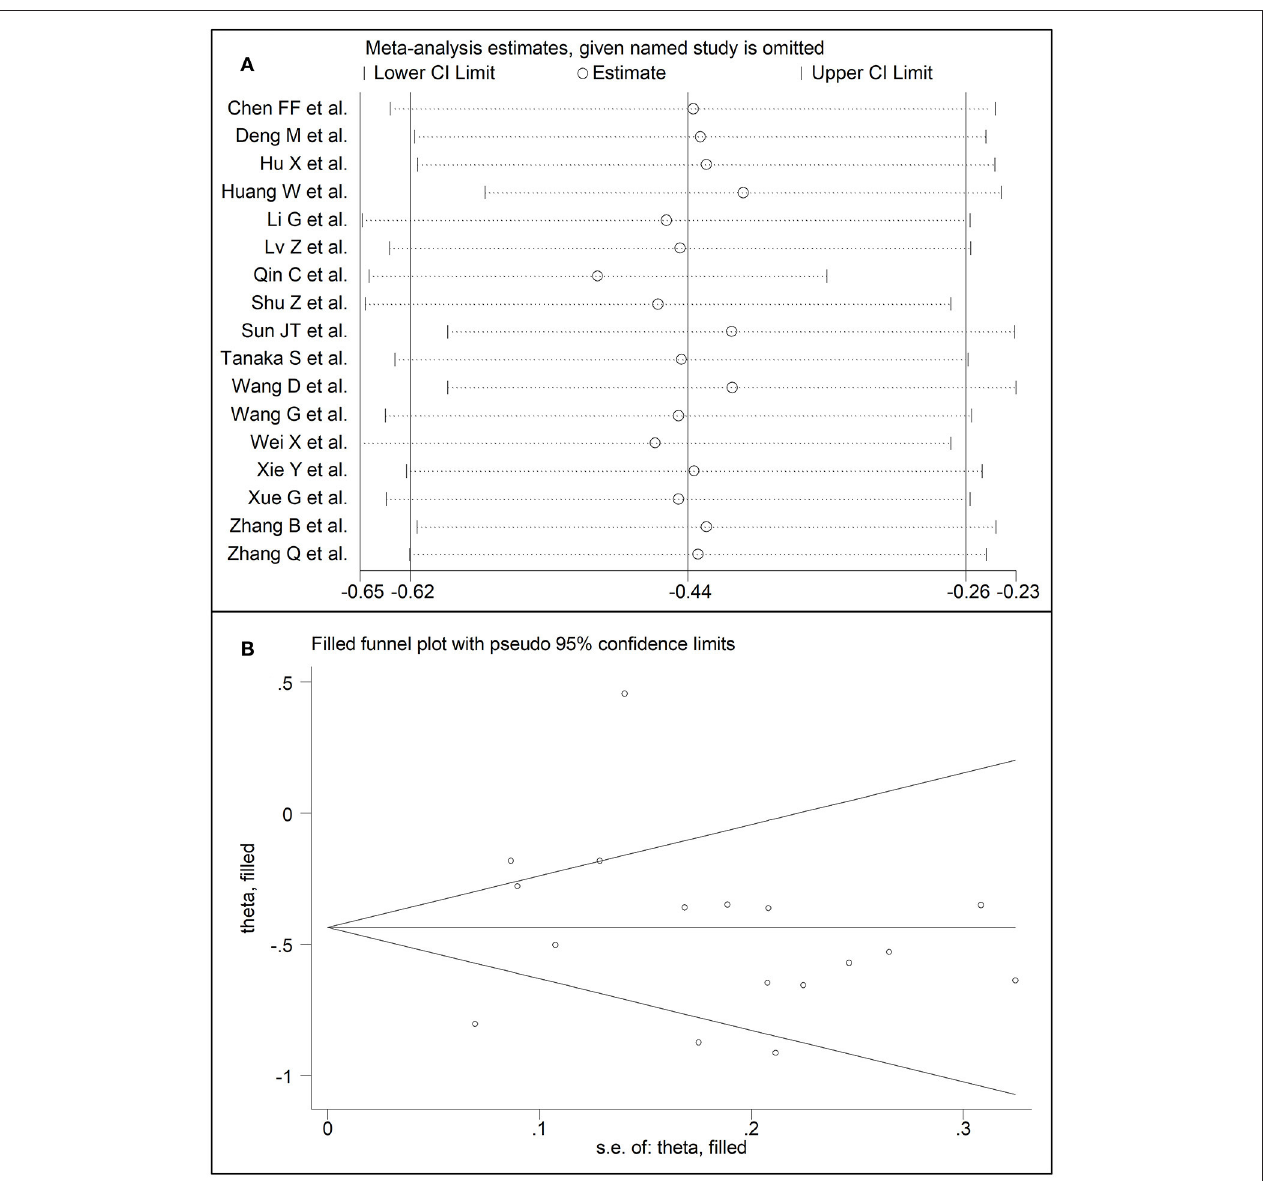
FIGURE 7 | (A) Sensitivity analysis of the association between HDL-cholesterol and COVID-19. The influence of individual studies on the overall standardized mean difference (SMD) is shown. The middle vertical axis indicates the overall SMD and the two vertical axes indicate the 95% confidence intervals (CIs). The hollow circles represent the pooled SMD when the remaining study is omitted from the meta-analysis. The two ends of each broken line represent the 95% CIs. (B) Funnel plot of studies investigating low vs. high severity or surviving vs. non-surviving status after trimming and filling. Dummy studies and genuine studies are represented by enclosed circles and free circles,